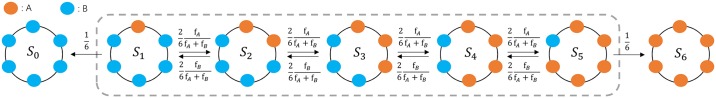
Markov chain for the Death-birth process.The states in the dashed box belong to the same equivalence class of the Markov chain, whereas two states outside the box are absorbing states, respectively. The Markov chain is one-dimensional, thus the fixation probability starting from an arbitrary state can be analytically solved. Here, the population size is six, i.e., N = 6.